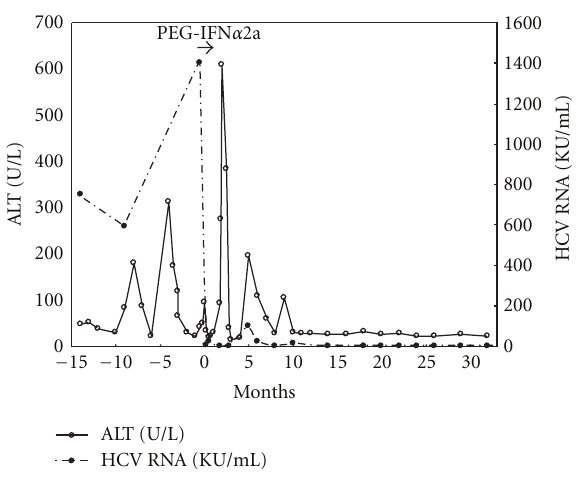
Figure 2: Biochemical and virological profile of the patients.